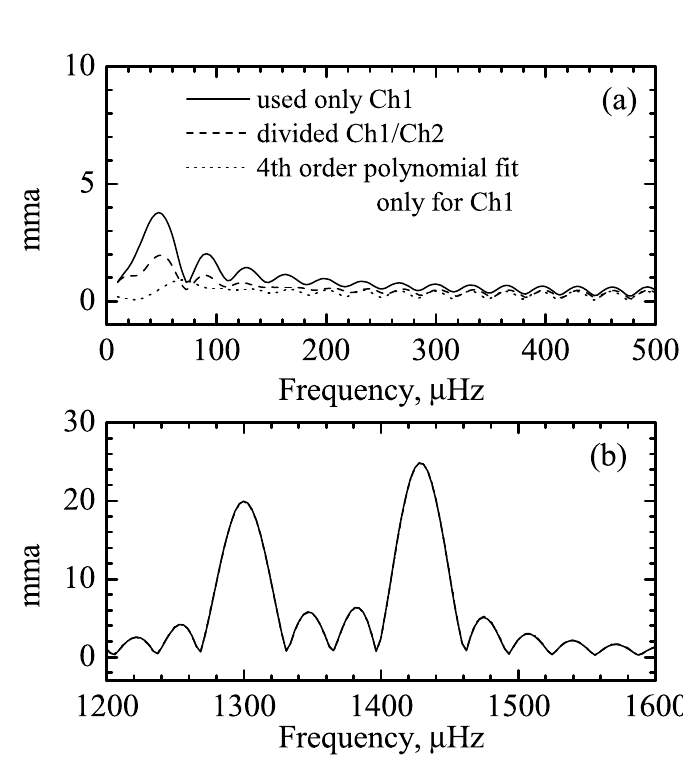
Fig. 11. FT for synthetic light curve when extinction is constant all the time, but the extinction correction methods are different: (a) – for frequencies between 0 and 500 μ Hz; (b) – for frequencies between 1200 and 1600 μ